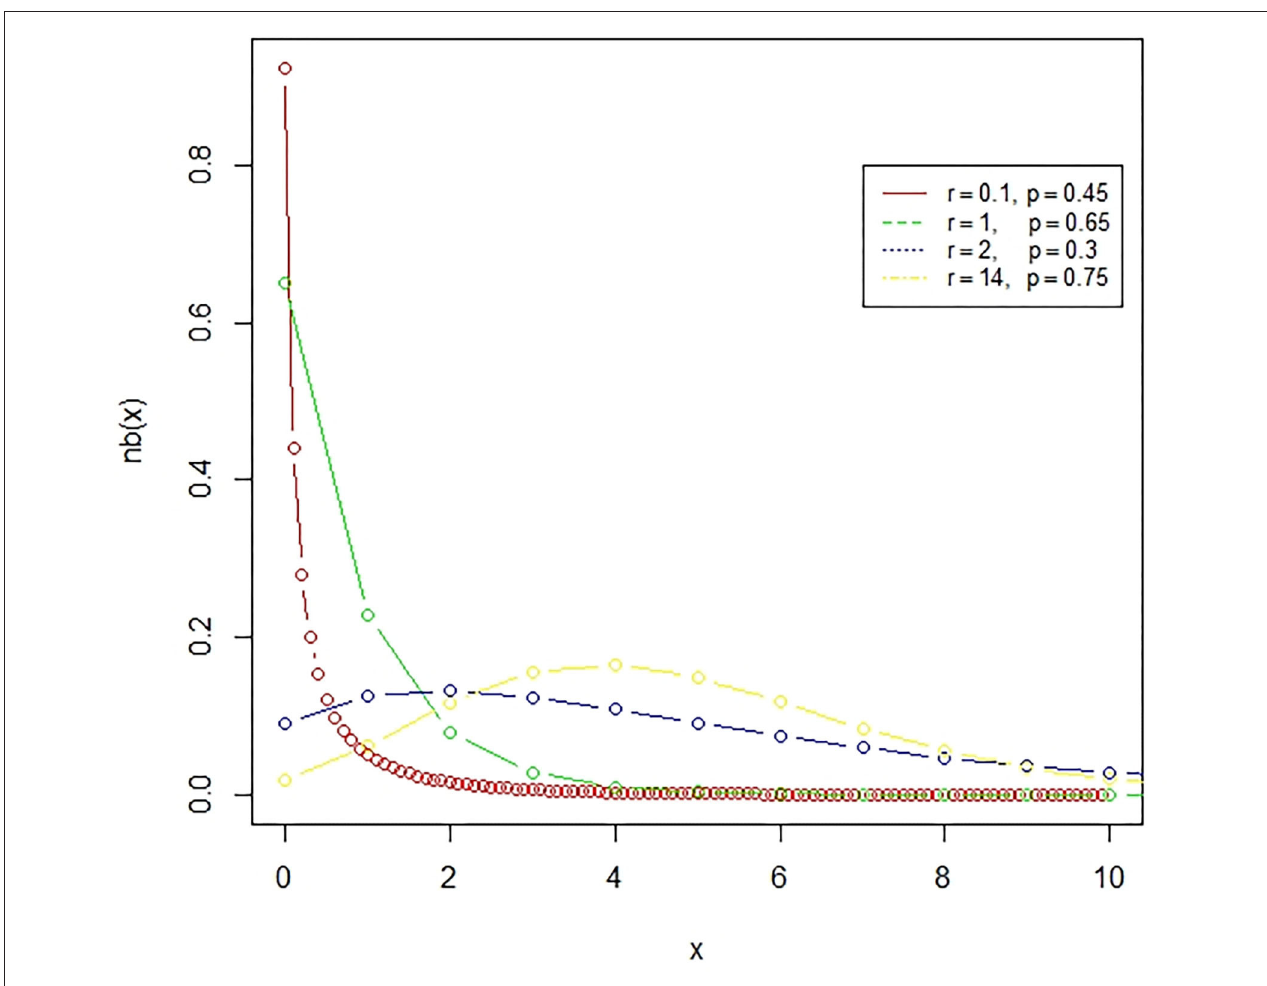
FIGURE 2 | The negative binomial distribution is a discrete probability distribution, which represents the number of failures in a sequence of independent and identically distributed Bernoulli trials till the required number of successes